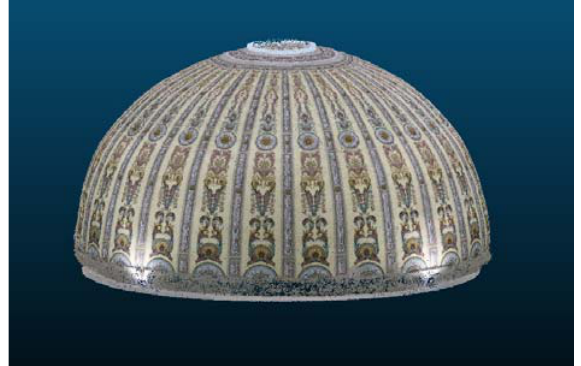
Figure 10: Photoscan dense point cloud